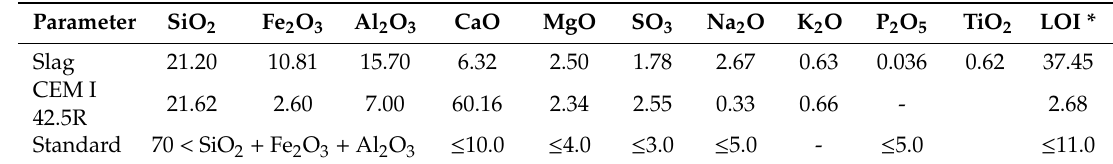
Table 1. Compositions (in weight percentages, wt.%) of the slag and CEM I 42.5R and values prescribed by the standard. Parameter